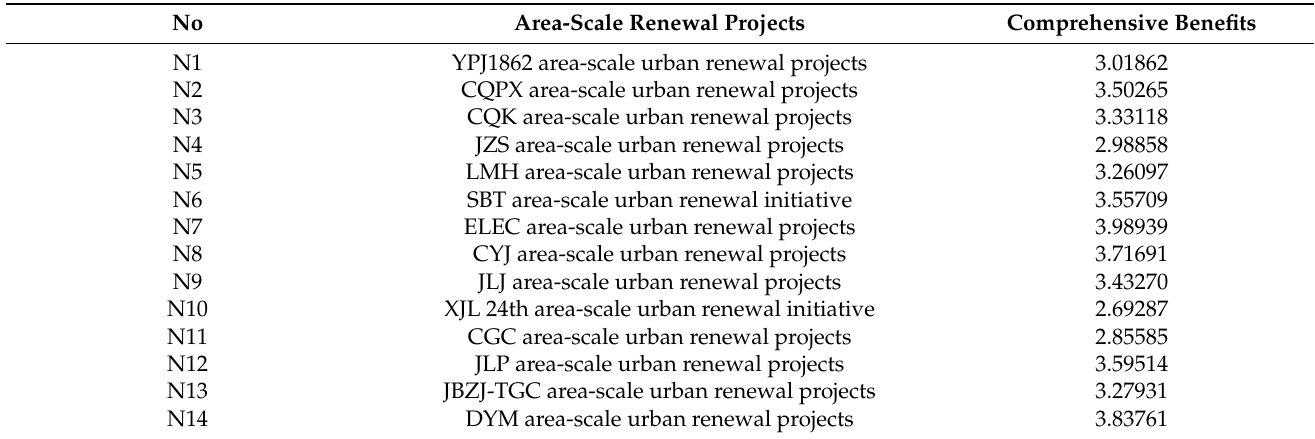
Table 5. The final evaluation value of comprehensive